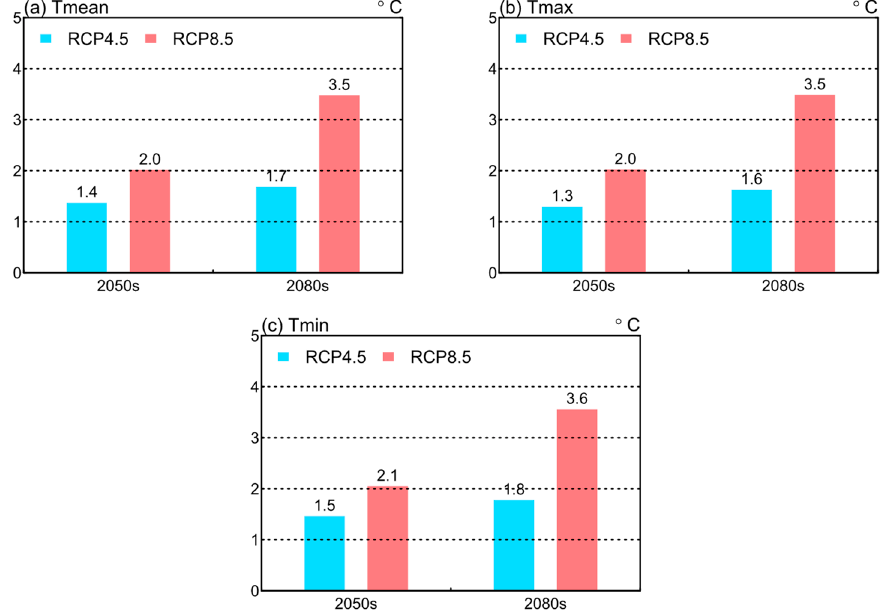
Figure 12. Spatial averages of projected changes for the future periods under RCPs. ( a ) T mean , ( b ) T max , and ( c ) T min .